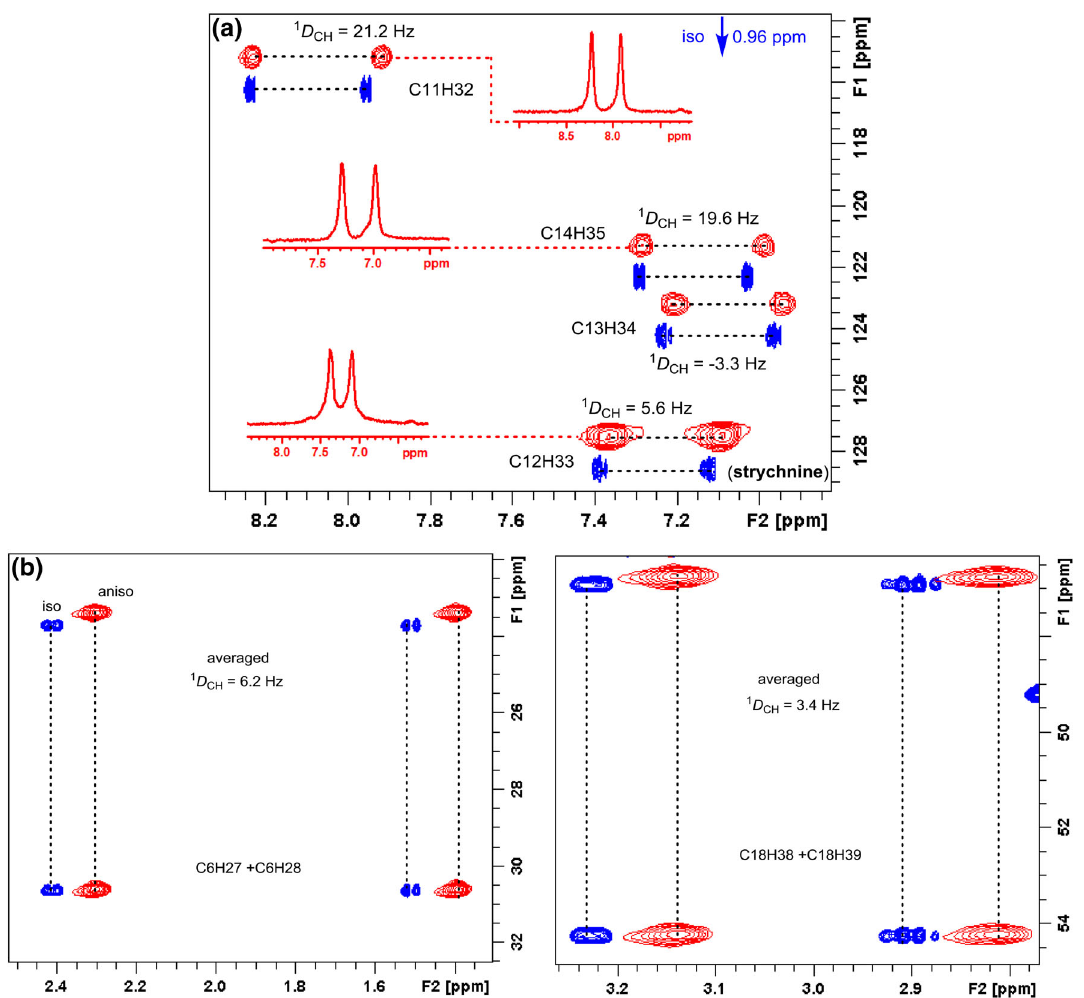
Fig. 5 ( a ) Expanded CLIP-HSQC spectra of strychnine in the isotropic CDCl 3 phase (blue contours) and in anisotropic L , L -PIAF- OBn LCs (red contours). The inserted trace from the anisotropic 2D spectra (C11/H32, C12/H33, C13/H34 and C14/H35) illustrates the